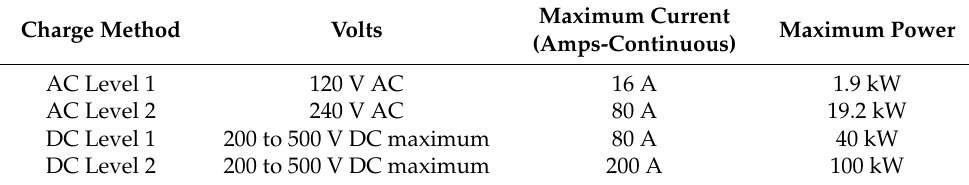
Table 4. Charge ratings of the SAE-J1772